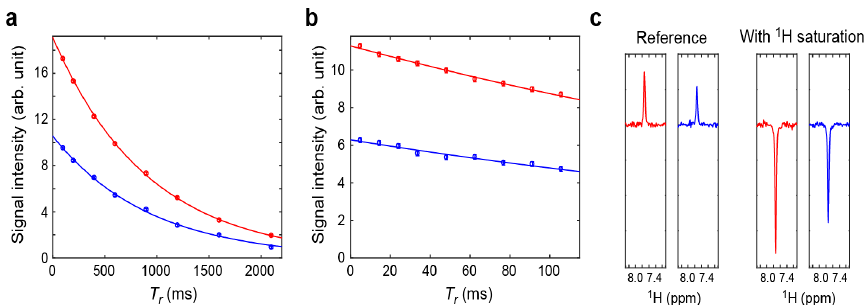
Figure 3. Comparison of the previous [15] and current pulse sequences for measuring 15 N relaxation of NH 3+ groups. ( a , b ) 15 N longitudinal (Panel a ) and transverse (Panel b ) relaxation of the K46 NH 3+ group. The vertical axis represents the signal intensity in the two-dimensional spectra measured as a function of the relaxation period T r . Solid lines represent the best-fit curves obtained through nonlinear least-squares fitting with a mono-exponential function; ( c ) Slices of the K46 NH 3+ signals along the 1 H dimension from the two-dimensional spectra with and without 1 H saturation for the heteronuclear NOE measurements. In each panel, data obtained with the previous and current pulse sequences are shown in blue and red, respectively.